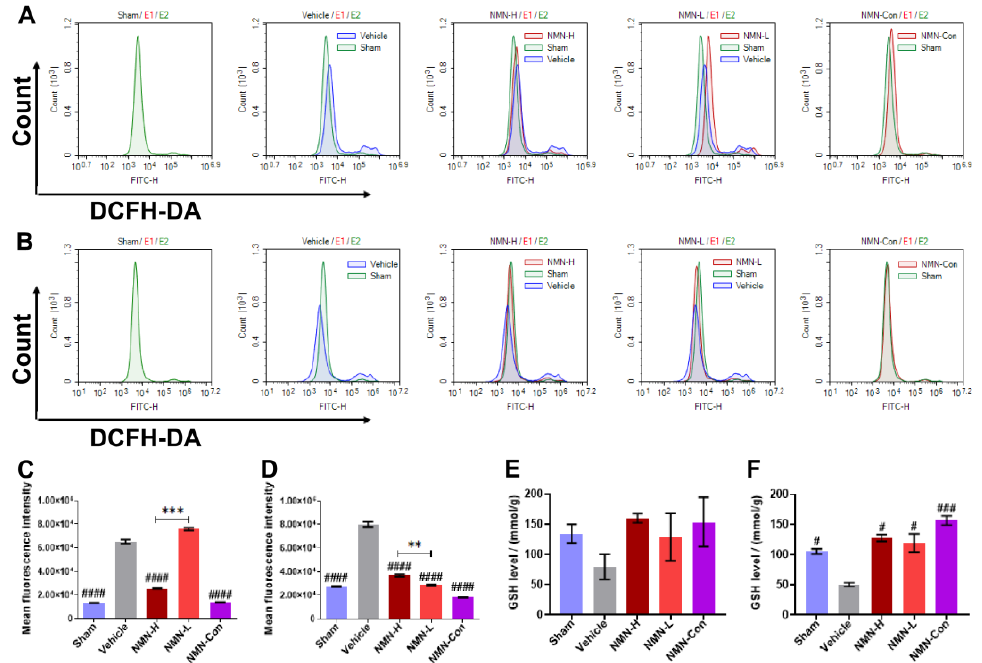
Figure 3. NMN intervention regulates the expression of ROS and GSH in silica-induced lung injury. ( A ) Histogram of ROS levels from flow cytometry after exposure to silica for 7 d; ( B ) histogram of ROS levels from flow cytometry after exposure to silica for 28 d; ( C ) expression of ROS in lung tissue at 7 d, analyzed using mean fluorescence intensity from flow cytometry; ( D ) expression of ROS in lung tissue at 28 d, analyzed using mean fluorescence intensity from flow cytometry; ( E ) expression of GSH in lung tissue at 7 d; ( F ) expression of GSH in lung tissue at 28 d. # indicates p < 0.05, ### p < 0.001, #### p < 0.0001 vs. Vehicle; ** p < 0.01, *** p < 0.001, NMN-H vs NMN-L. ROS: reactive oxygen species, GSH: glutathione. Sham: saline + saline; Vehicle: silica + saline; NMN-H: silica + NMN (1000 mg/kg); NMN-L: silica + NMN (500 mg/kg); NMN-Con: saline + NMN (1000 mg/kg).